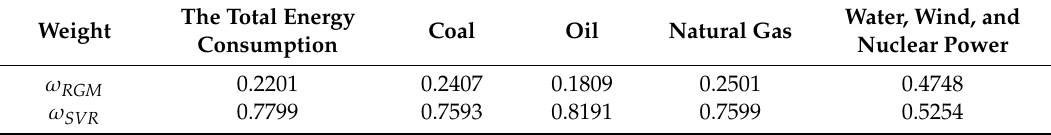
Table 6. Weight distribution of